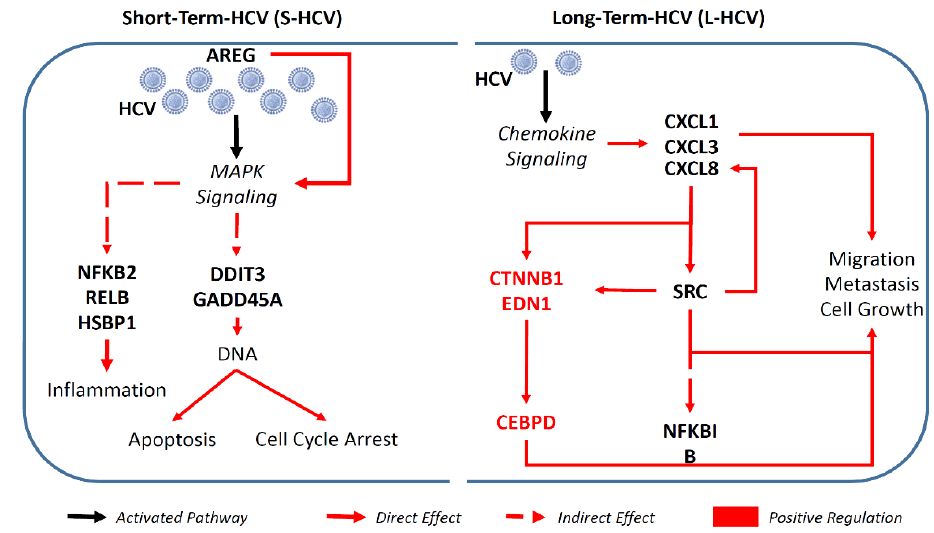
Figure 7. A graphical summary illustrating how intracellular HCV—short-term HCV (S-HCV), and long-term HCV (L-HCV)—activated signaling pathways with different genes, which resulted in different effects in cellular microenvironments, respectively.